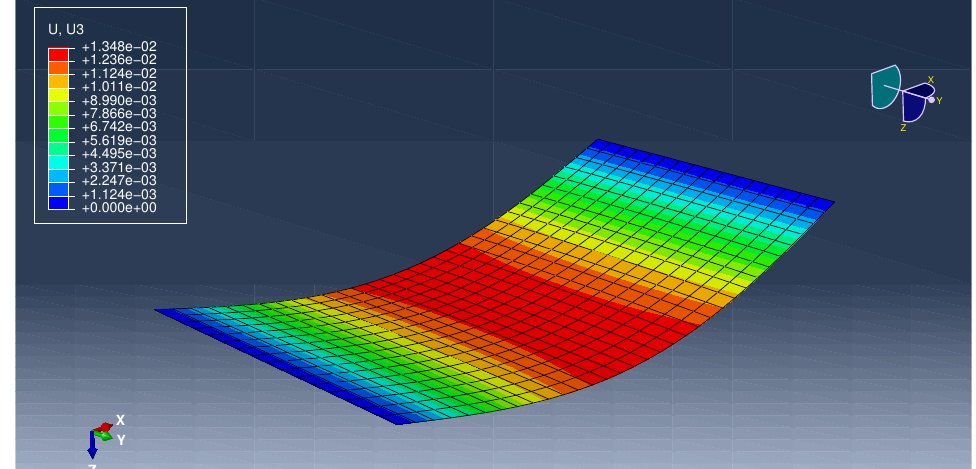
Figure A1. The deflection of a rectangular plate with two opposite edges simply supported and the other free solved using